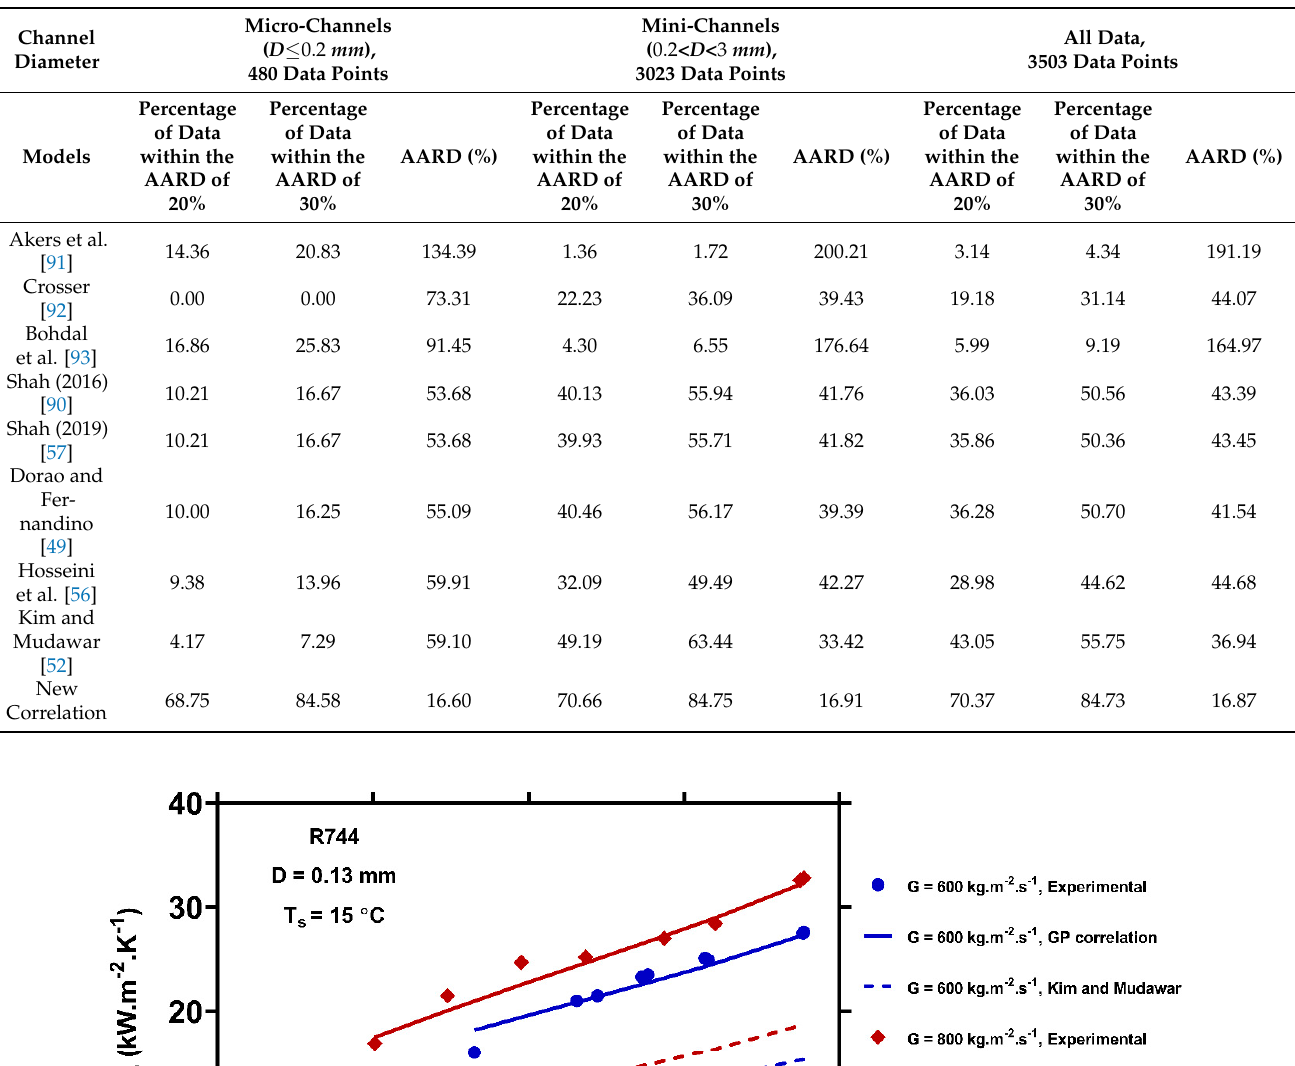
Table 5. Comparison of the accuracy of the available models for estimating the HTC in multi-port micro and mini-channels.